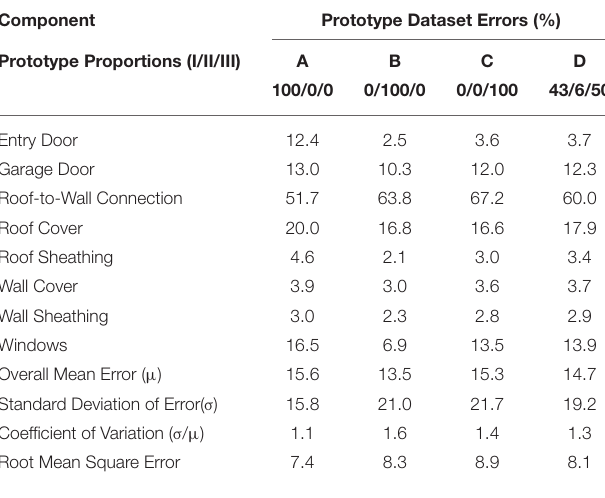
TABLE 4 | Percent weighted mean component error for each prototype